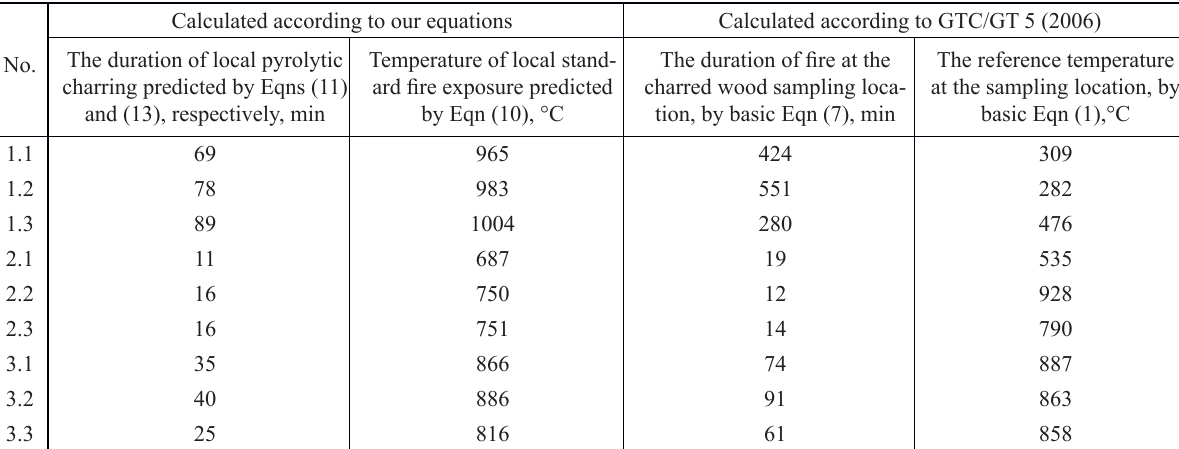
Table 5. Forecasted values of time and temperature Calculated according to our equations Calculated according to GTC/GT 5 (2006) The duration of local pyrolytic Temperature of local stand- No. charring predicted by Eqns (11) ard fire exposure and (13), respectively, min